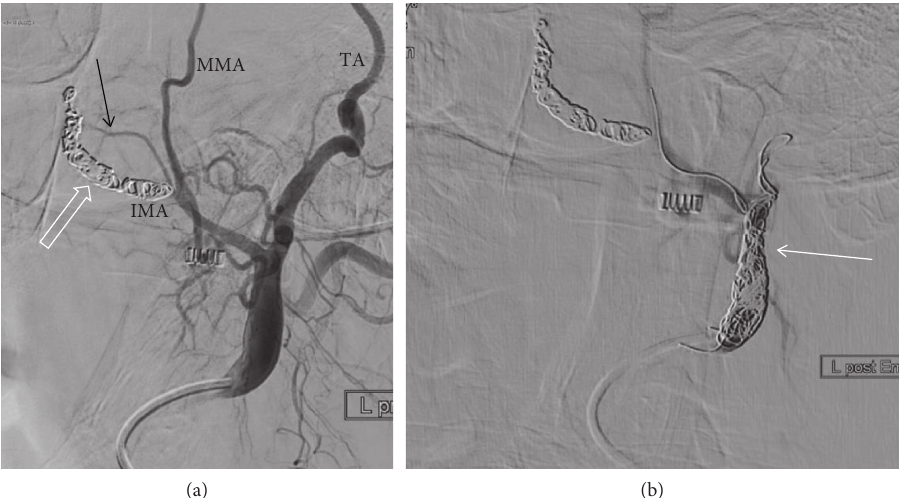
Figure 4: Re-embolization of left external carotid artery (ECA) due to an accessory artery from IMA in a 72-year-old male patient with epistaxis (risk factor: anticoagulation). (a) Angiogram of ECA shows coils in the internal maxillary artery (IMA) and sphenopalatine artery (SPA, open white arrow) after embolization 53 days earlier. However, there is an accessory artery rising from of the proximal IMA (black arrow), then running to the dorsal part of the nasal cavity, potentially being responsible for the rebleeding. (b) Decision was made to embolize the ECA to stop the blood supply to this artery. No particles were used. Embolization was performed with coils (white arrow). Also shown are middle meningeal artery (MMA) and temporal artery